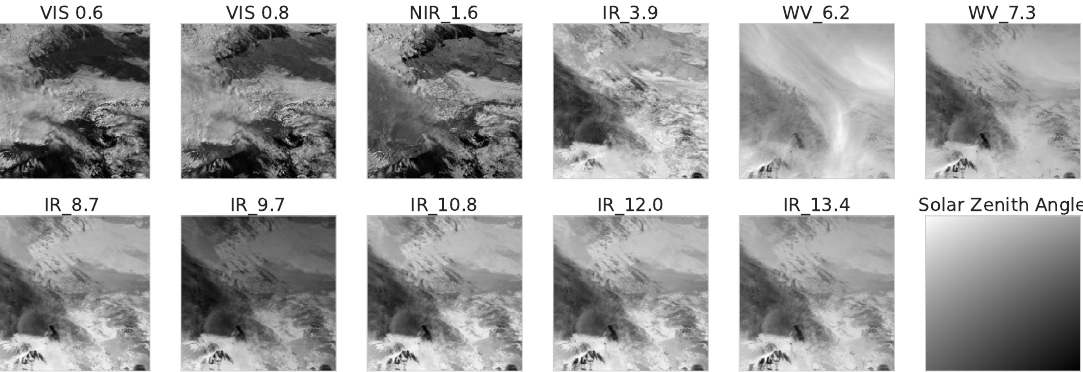
Figure 2. An overview over all SEVIRI channels from 22 February 2011 at 09:00:00 UTC. The channel names contain the central wavelength of each channel in micrometers. Additionally, the solar zenith angle for the same date is displayed in the bottom row on the right (black means large angle, white small